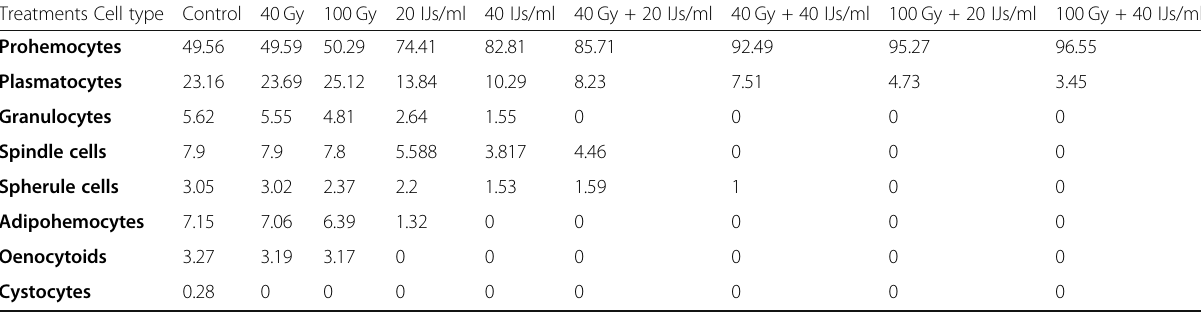
Table 2 Hemocyte percentage of F1 Galleria mellonella larvae (irradiated parent male pupae with 40 or 100Gy) alone or combined with Steinernema carpocapsae BA2 (20 and 40 IJs/ml)